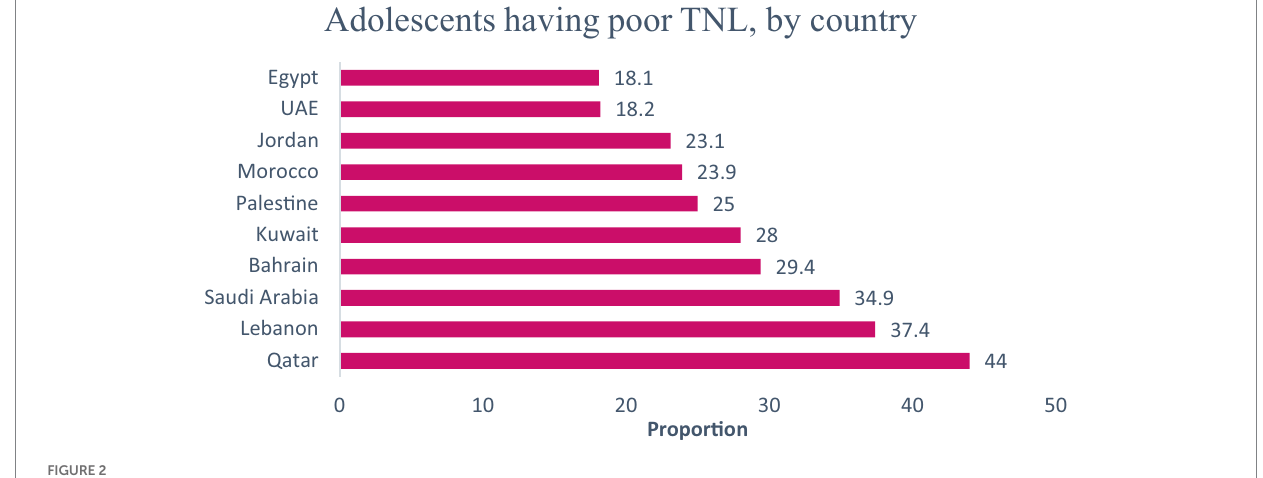
FIGURE 2 The proportion of adolescents having poor total nutrition literacy (TNL), by